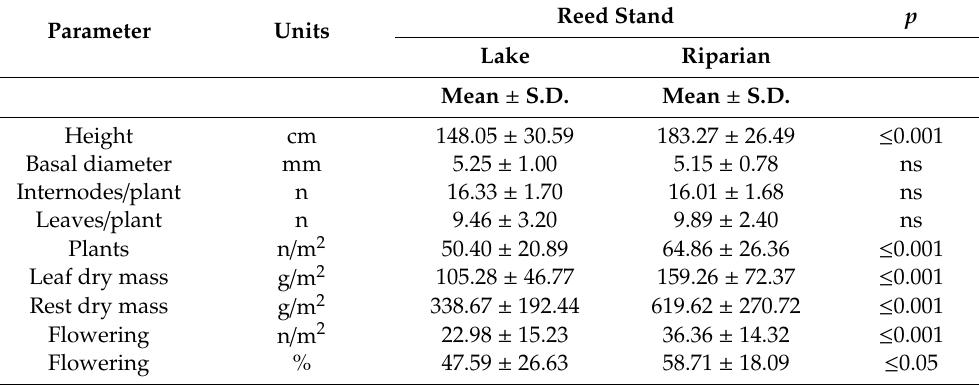
Table 1. Productivity parameters for the common reed from the lake (Zadnji Kraj) and riparian (Gorenje Jezero) reed stands from 2007 to